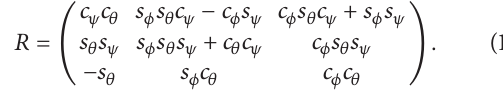
⃗𝑉 = [𝑢 V 𝜔] 𝑇 correspondent body linear velocity vector ⃗Ω = [𝑝 𝑞 𝑟] 𝑇 and angular rate vector . Another one is an Earth-fixed inertial (also known as navigation) coordinate system 𝐸 = (𝑋 𝐸 , 𝑌 𝐸 , 𝑍 𝐸 ) with which initially the body- fixed coincides. The attitude of the quadrotor, expressed in terms of the Euler angles 𝜙 (roll), 𝜃 (pitch), and 𝜓 (yaw), is evaluated via sequent rotations around each one of the (North-East- inertial axes. Herein, a reference frame by 𝑂 NED Down) denotes an inertial reference frame and 𝑂 𝐵 a body- fixed reference